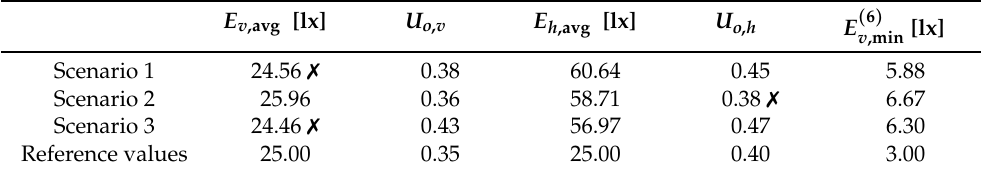
Table 3. Photometry for modified crosswalk layouts (the PC4 class was assumed). The symbol (cid:55) denotes violating standard